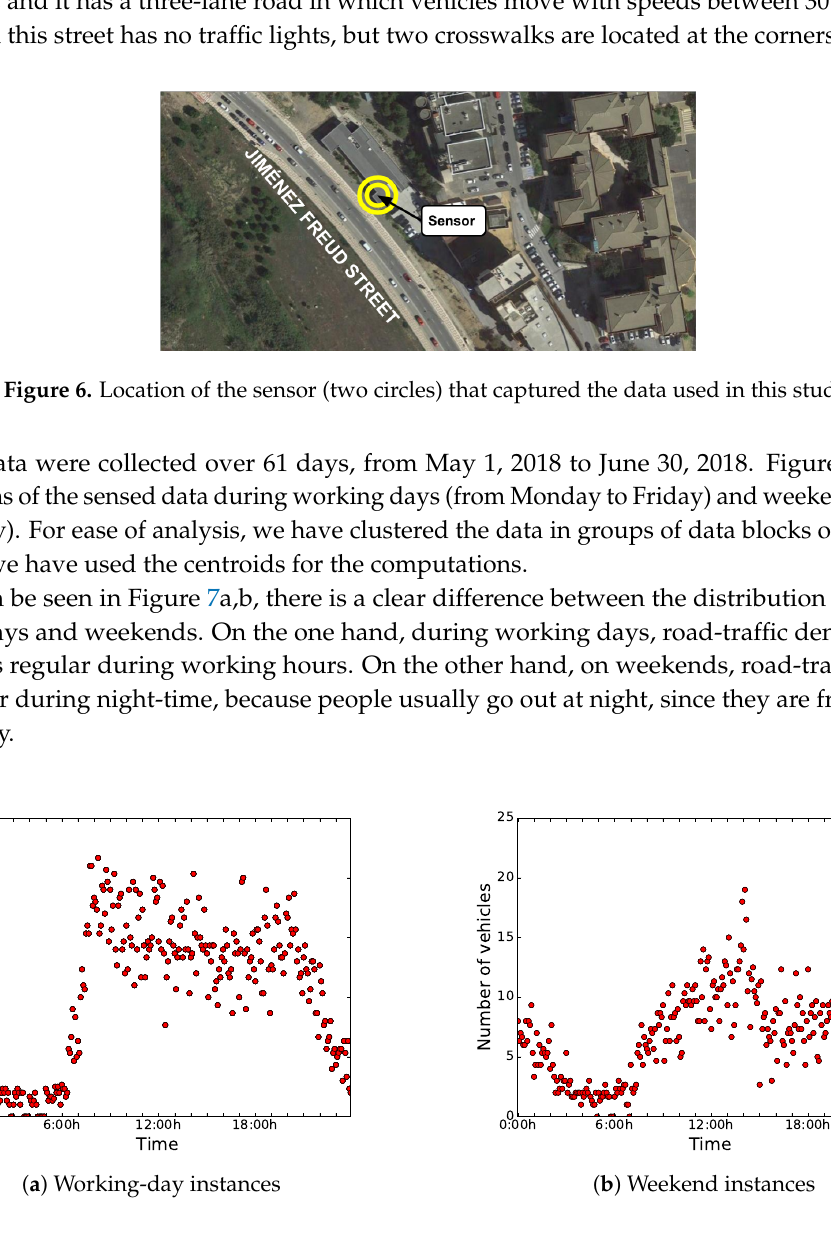
Figure 7. Clustered data regarding number of vehicles sensed every five